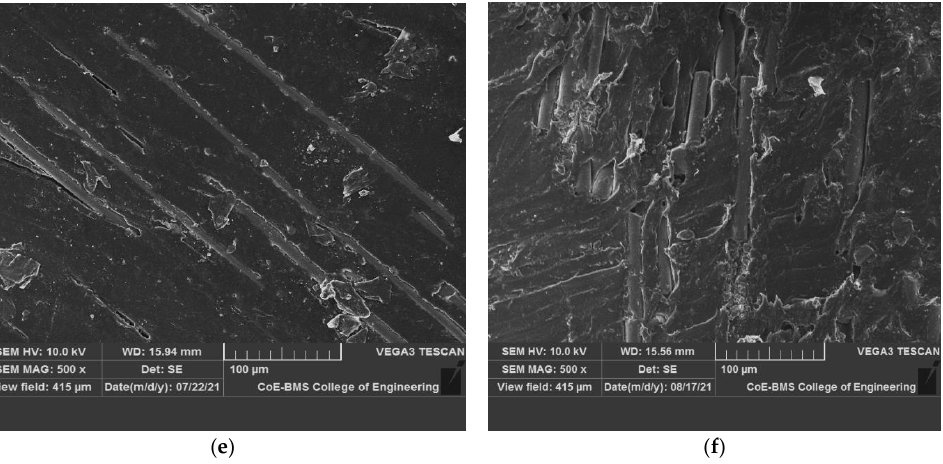
Figure 7. SEM of ABS composite reinforced with different percentage of short glass fibre. ( a ) ABS + 15% SGF; ( b ) ABS+30% SGF; ( c ) ABS + 15% SGF; ( d ) ABS + 30% SGF; ( e ) ABS + 15% SGF; ( f ) ABS + 30% SGF.